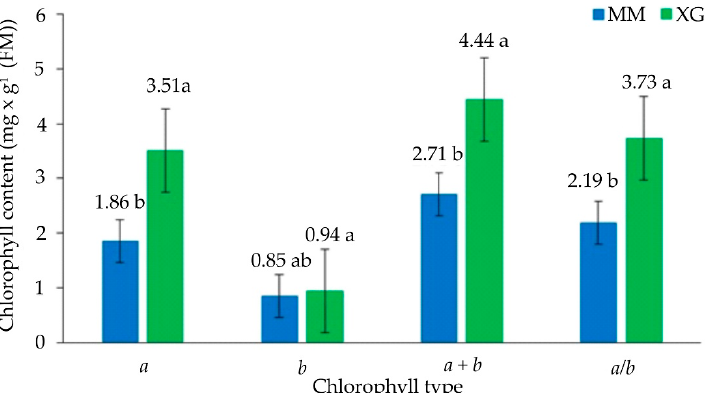
Figure 3. Chlorophyll content in the leaves of Filipendula vulgaris Moench collected from the Molinia meadows (MM) and xerothermic grasslands (XG); a —content of chlorophyll a , b —content of chlo- rophyll b , total chlorophyll —a + b , ratio chlorophyll a to b — a / b ; mean values (n = 5, ± SD) marked with different letters differ significantly according to Tukey’s test (for different N) at p ≤ 0.05. The shape of the blue–green and red fluorescence spectra in F. vulgaris from the Molinia meadows (MM) and xerothermic grasslands (XG) was similar (Figure 4A,B). The blue–green fluorescence spectra showed a slight peak at approximately 535 nm and a sec- ond peak at 590 nm (Figure 4A). In the case of red fluorescence, a strong peak of fluores- cence was observed at approximately 690 nm, with a very distinct shoulder at 735 nm (Figure 4B). The fluorescence intensity was higher in the plants from the areas of xerother- mic grasslands (XG) than in the Molinia meadows (MM). Significant differences in the val- ues of the fluorescence emission coefficients were demonstrated between F. vulgaris plants from meadows and grasslands (Table 2). Table 2. Fluorescence emission coefficients of Filipendula vulgaris Moench leaves collected from the areas of Molinia meadows (MM) and xerothermic grasslands (XG); mean values (n = 5, ± SD) marked with different letters a, b differ significantly according to Tukey’s test (for different N) at p ≤ 0.05.